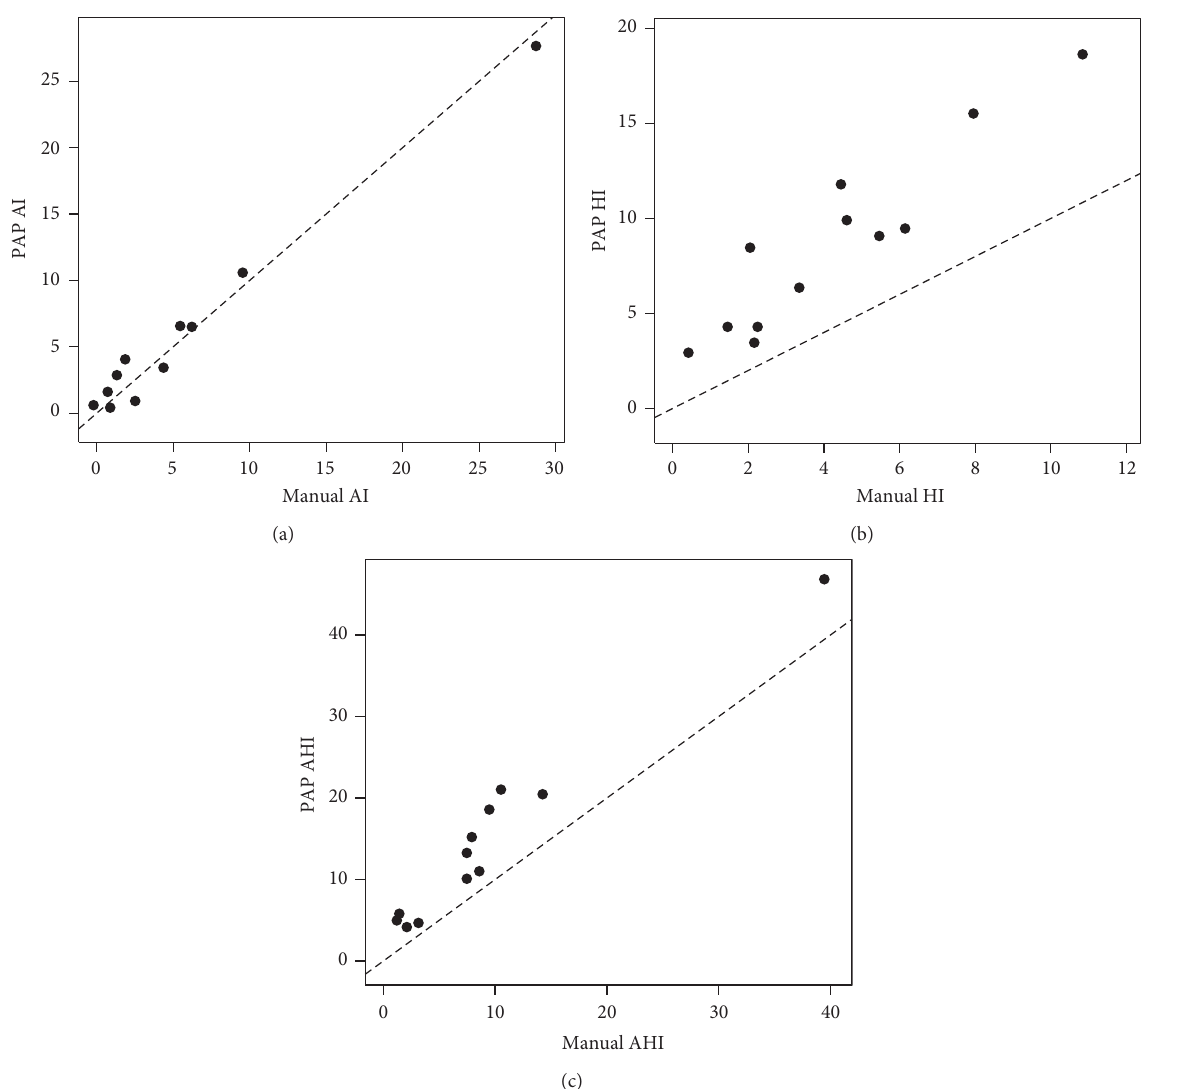
Figure 1: (a) Scatterplot of PAP-scored versus manual-scored Apnea Index. Each point represents one night. The diagonal line represents the line of identity. (b) Scatterplot of PAP-scored versus manual-scored Hypopnea Index. Each point represents one night. The diagonal line represents the line of identity. Note that all PAP HI values are greater than manual HI values. (c) Scatterplot of PAP-scored versus manual- scored Apnea-Hypopnea Index. Each point represents one night. The diagonal line represents the line of identity. Note that all values of PAP AHI are greater than manual AHI